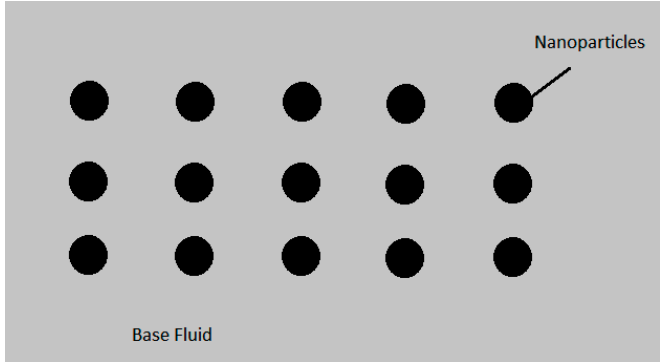
Figure 27. A representation of the effective medium theory showing the base fluid in grey, and the nanoparticles depicted as black circles. nanoparticles depicted as black